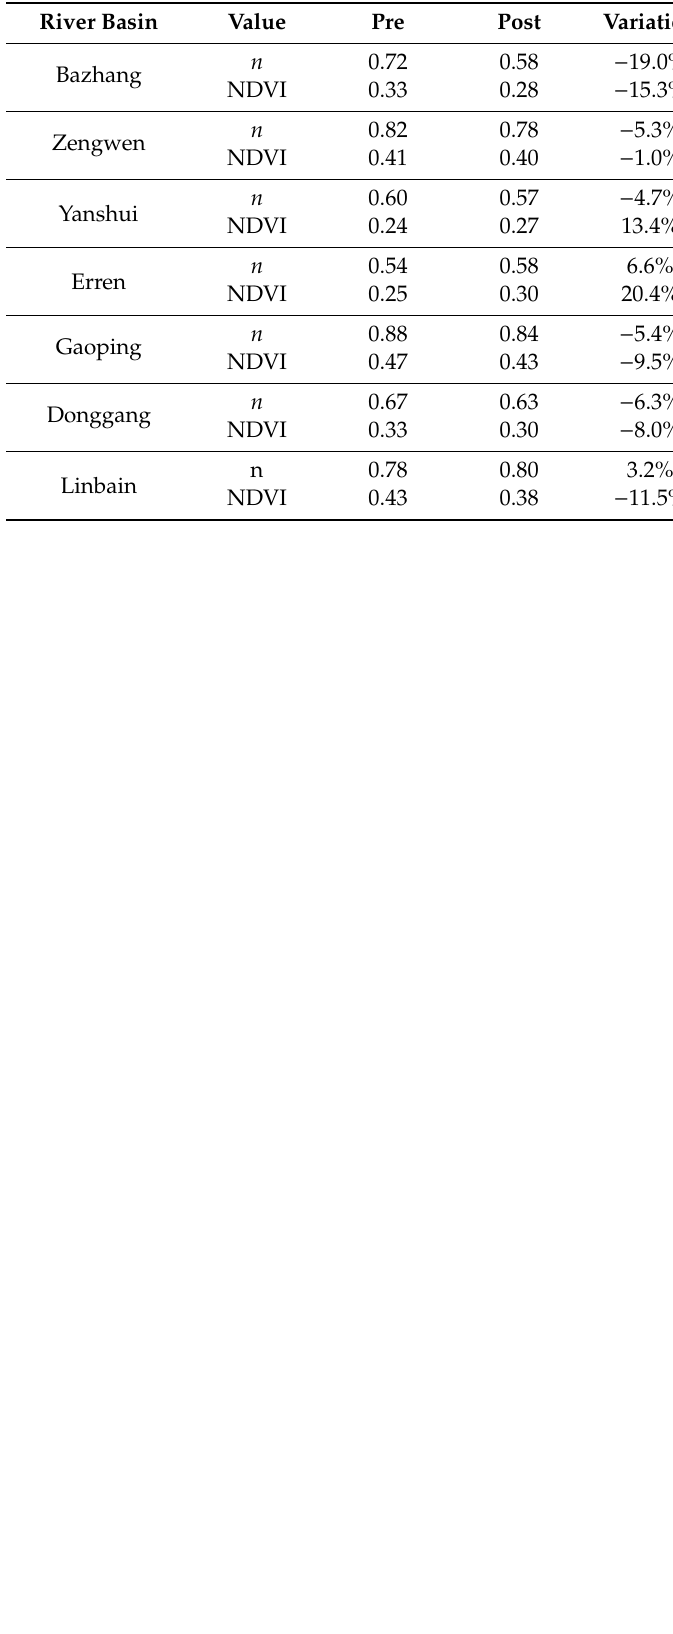
Table 8. Comparison of the n and NDVI (Normalized Di ff erence Vegetation Index) variations from pre- to post-period in each river